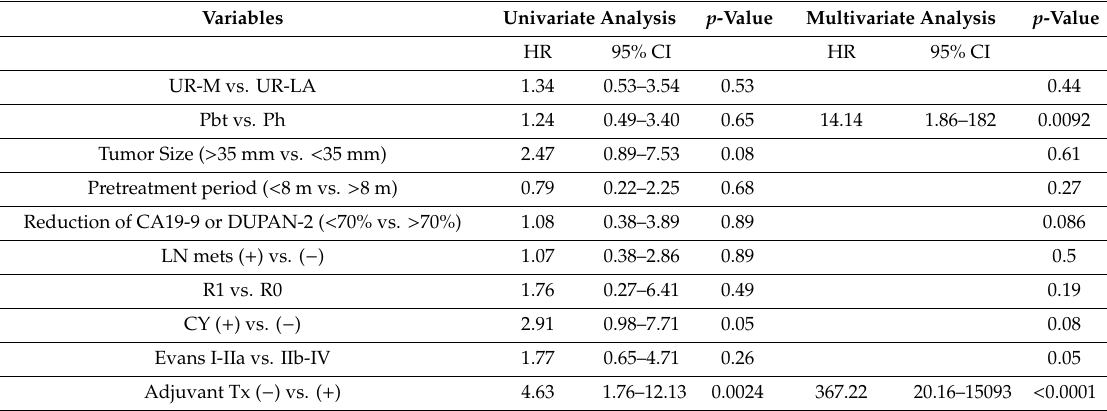
Table 4. Univariate and multivariate analysis of prognostic factor of overall survival in CS group. Variables Univariate Analysis p -Value Multivariate Analysis p -Value HR 95% CI HR 95%